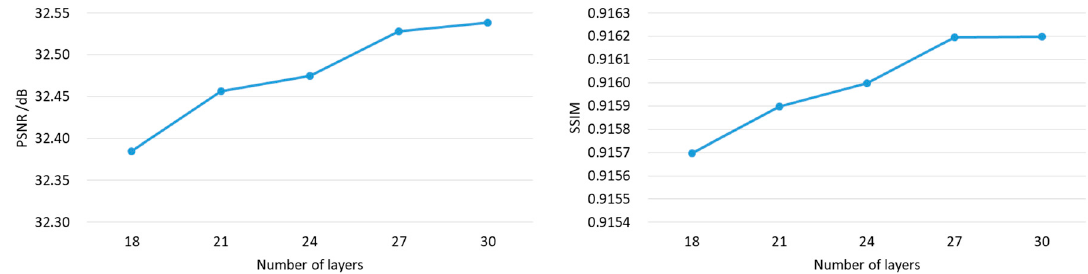
Figure 4. The average PSNR & SSIM upscaling factor 2 & 3 versus different layers CNNs under 50-epoch training when applied to the 12-image test set.